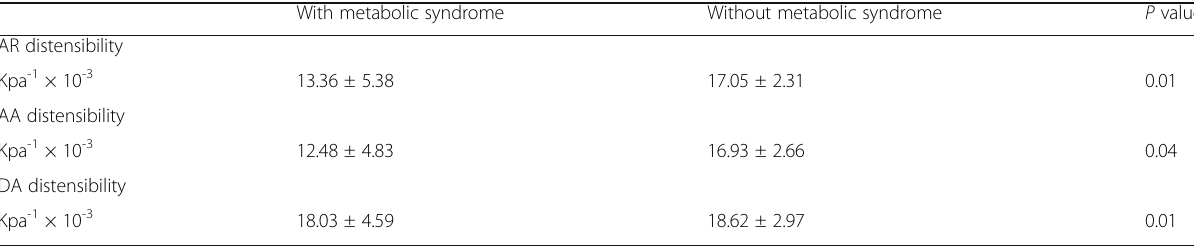
Table 5 Aortic distensibility in studied patients based on the presence of the metabolic syndrome With metabolic